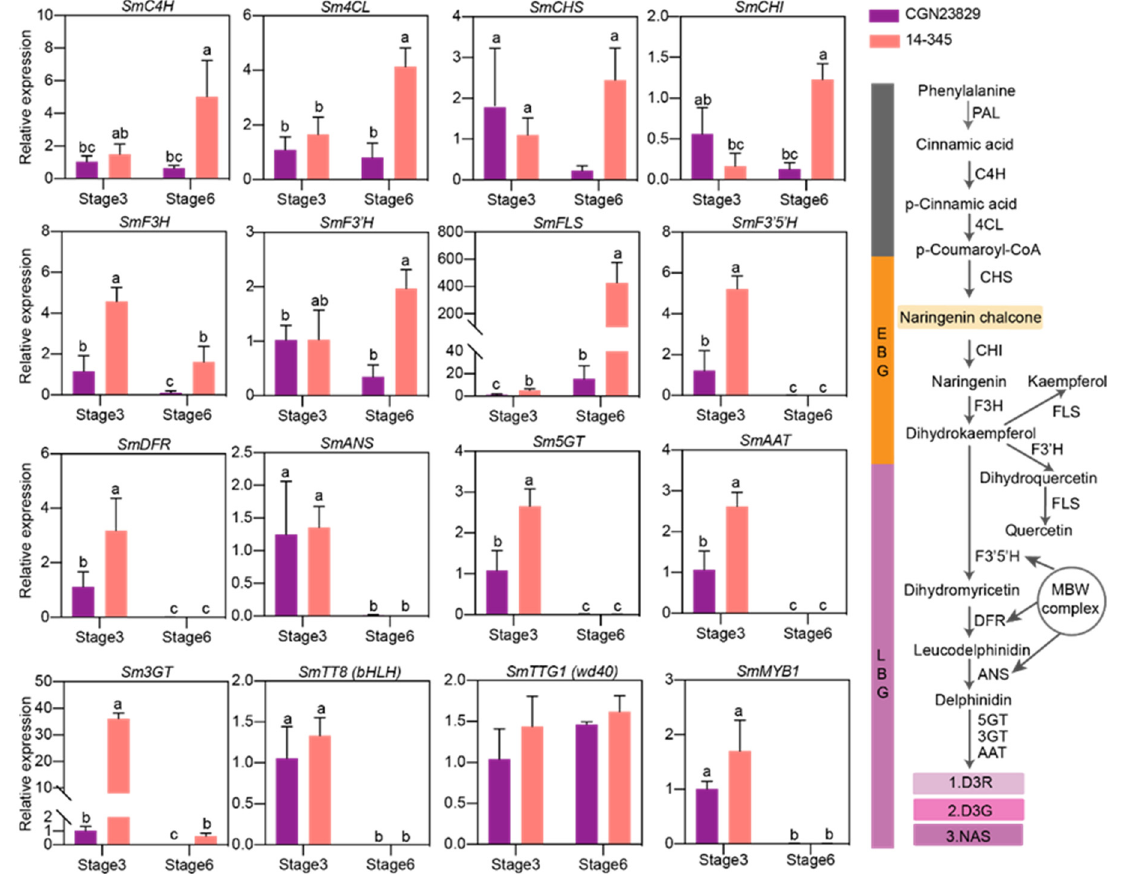
Figure 4. Analysis of expression of selected genes involved in flavonoid biosynthesis pathway. The arrows indicate the flow direction of the pathway. MBW complex in the cycle indicates MYB-bHLH-WD40 complex. Different lower letters indicate significant differences according to Student’ s t -test ( p <